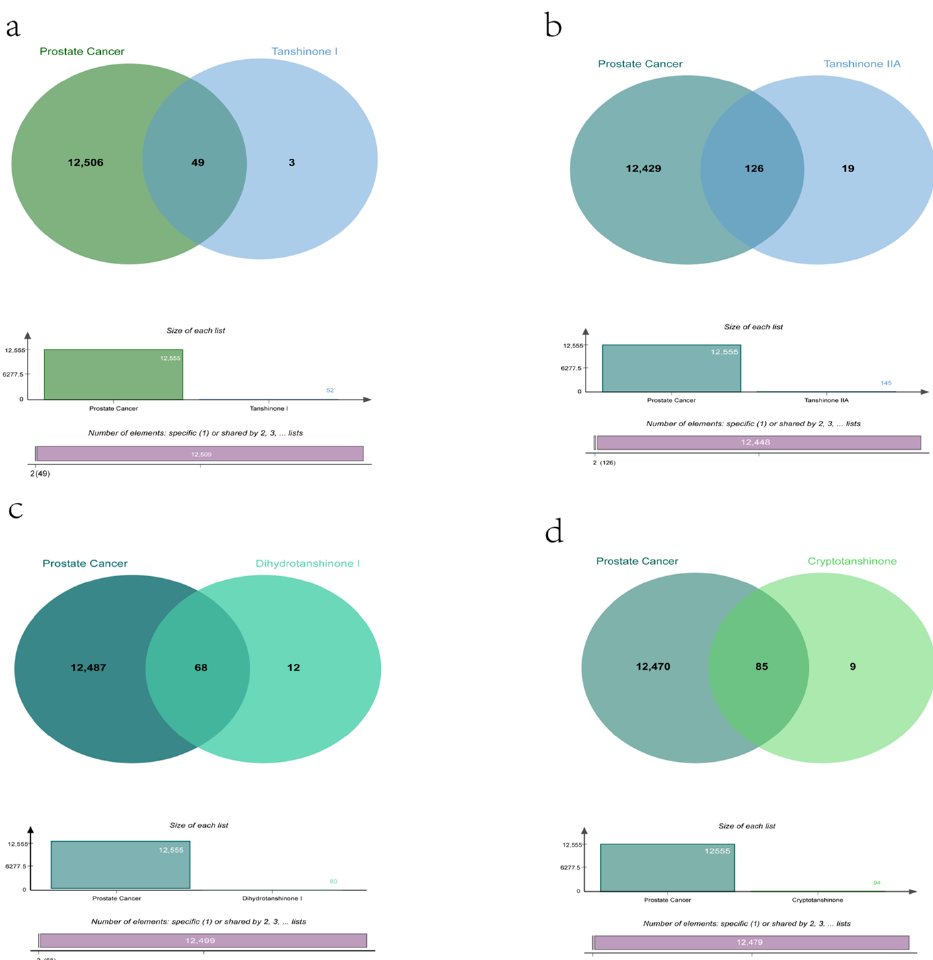
Figure 4. Venny of four components of Tanshinone (( a ): Tanshinone I and Prostate Cancer; ( b ): Tanshinone IIA and Prostate Cancer; ( c ): Dihydrotanshinone I and Prostate Cancer; ( d ): Cryptotanshinone and Prostate Cancer).